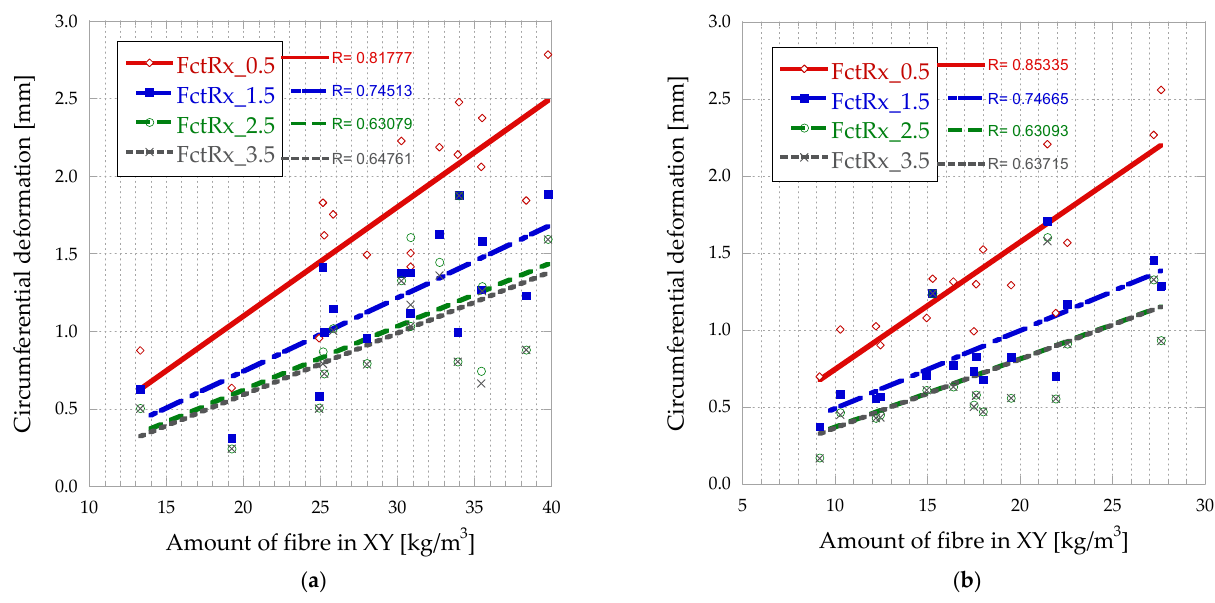
Figure 16. Amount of fibre in XY vs. circumferential deformations in BH-bottom ( a ) and BH-top ( b ).